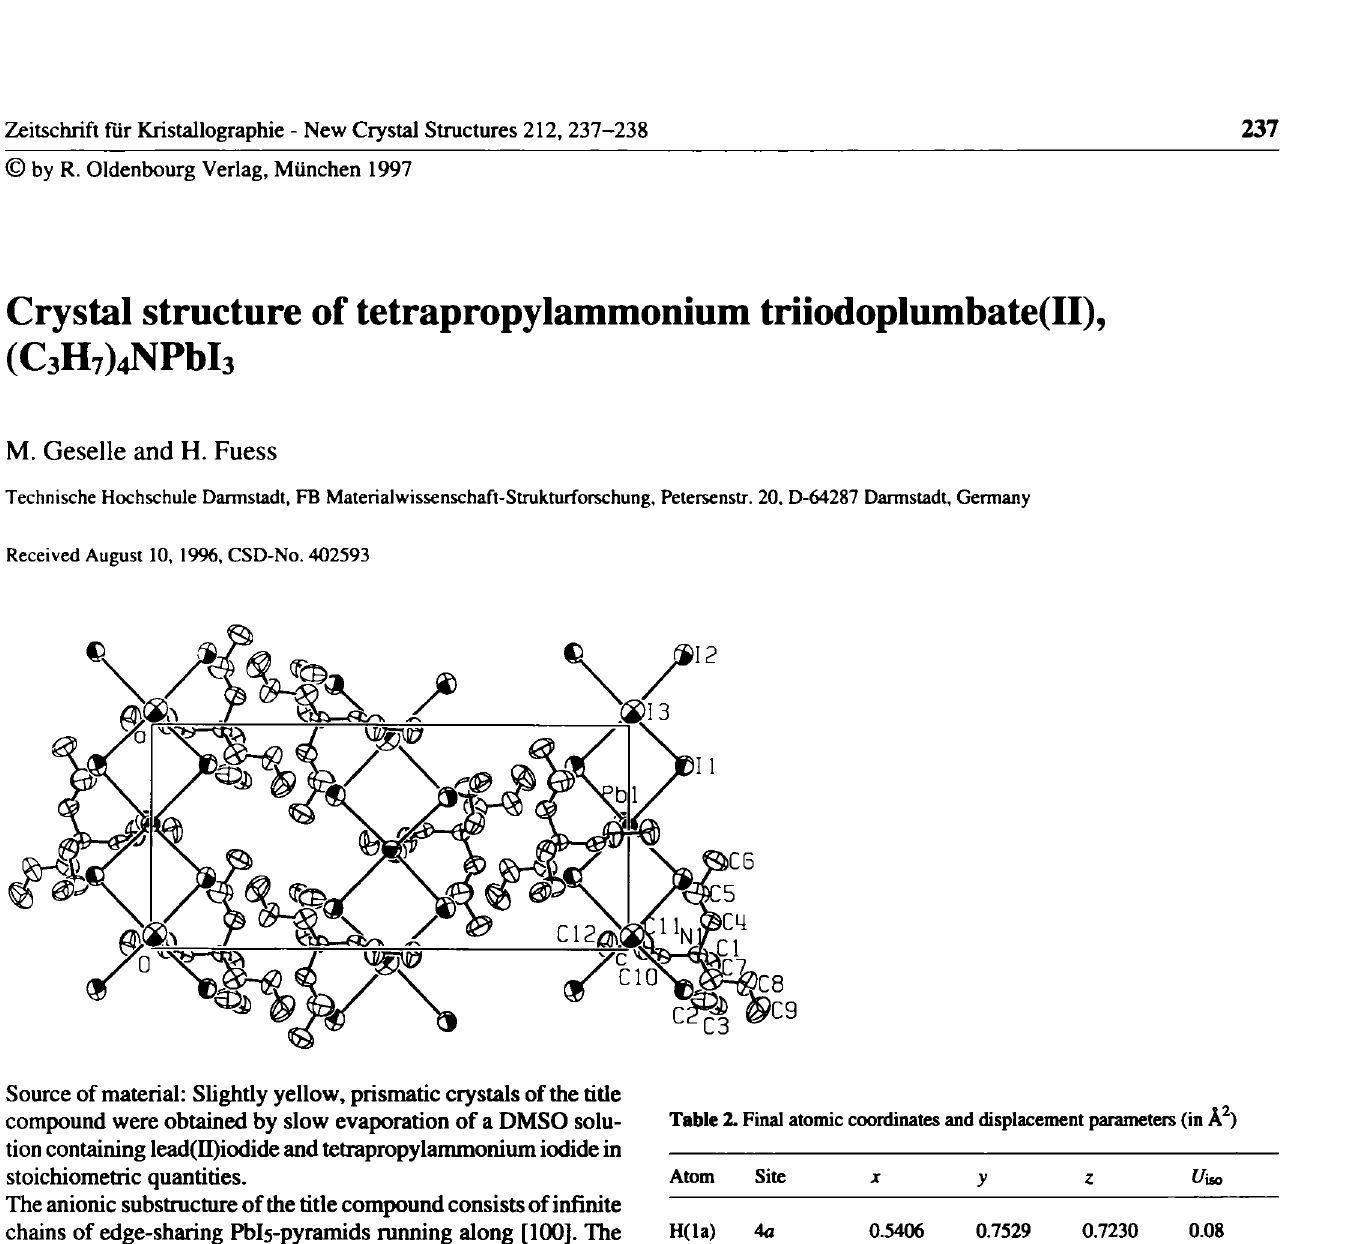
Table 1. Parameters used for the X-ray data collection